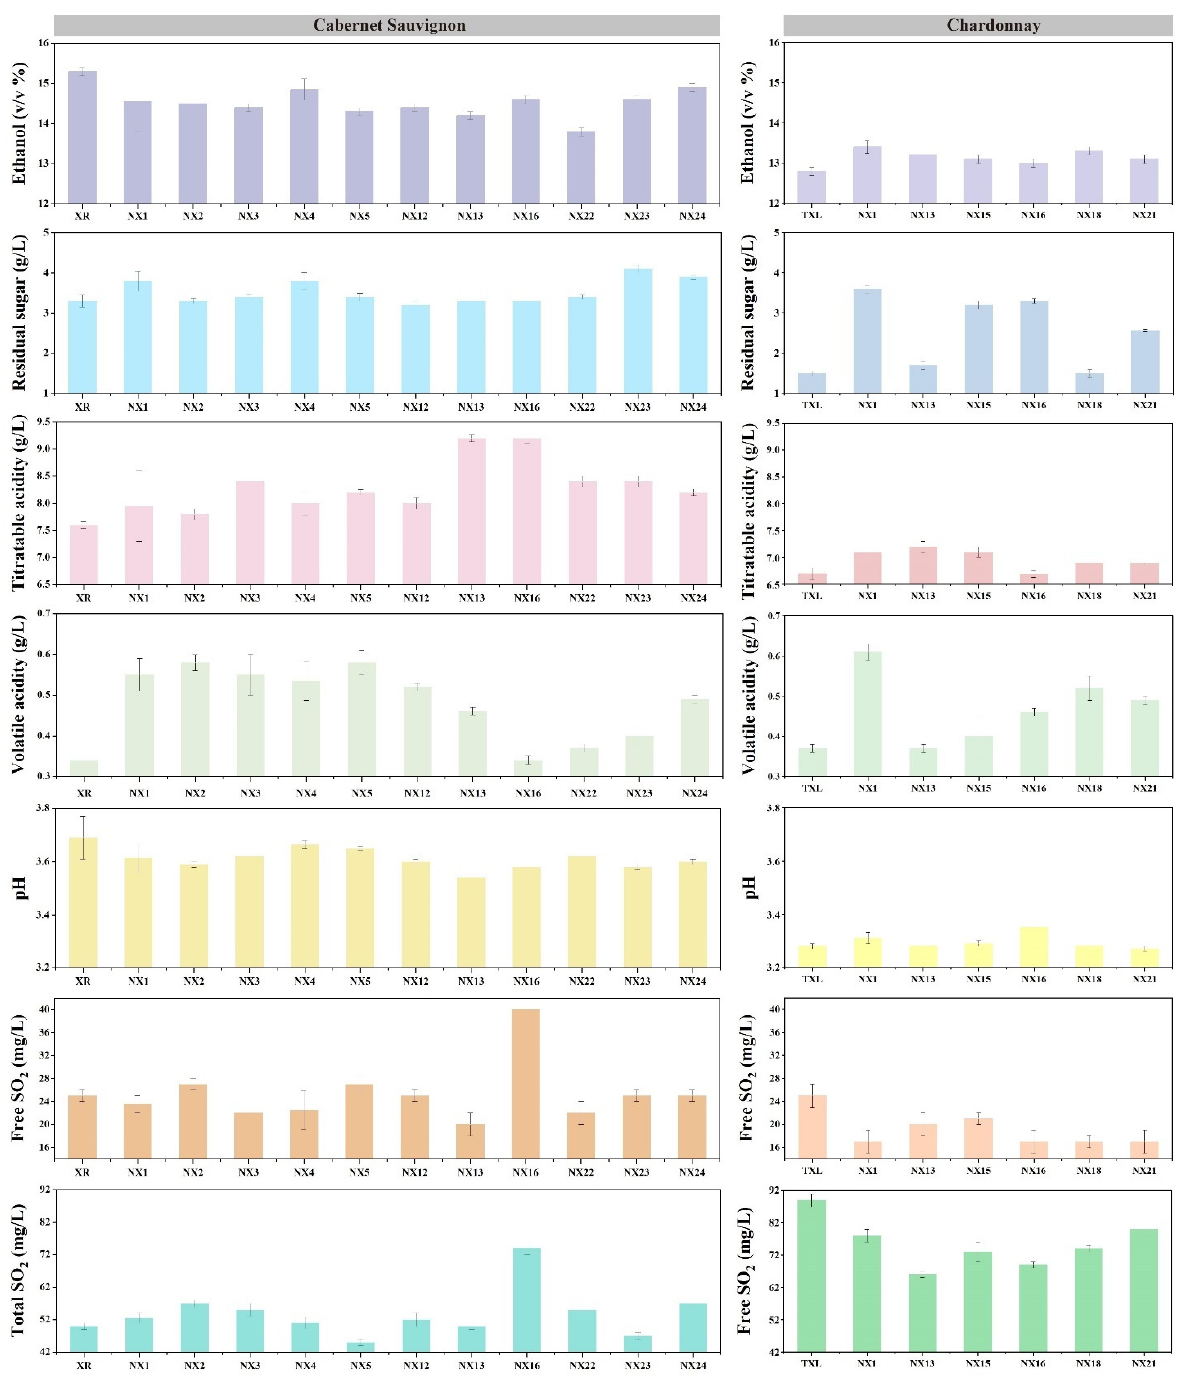
Figure 4. Physiochemical parameters of Cabernet Sauvignon and Chardonnay wines fermented by indigenous S. cerevisiae .